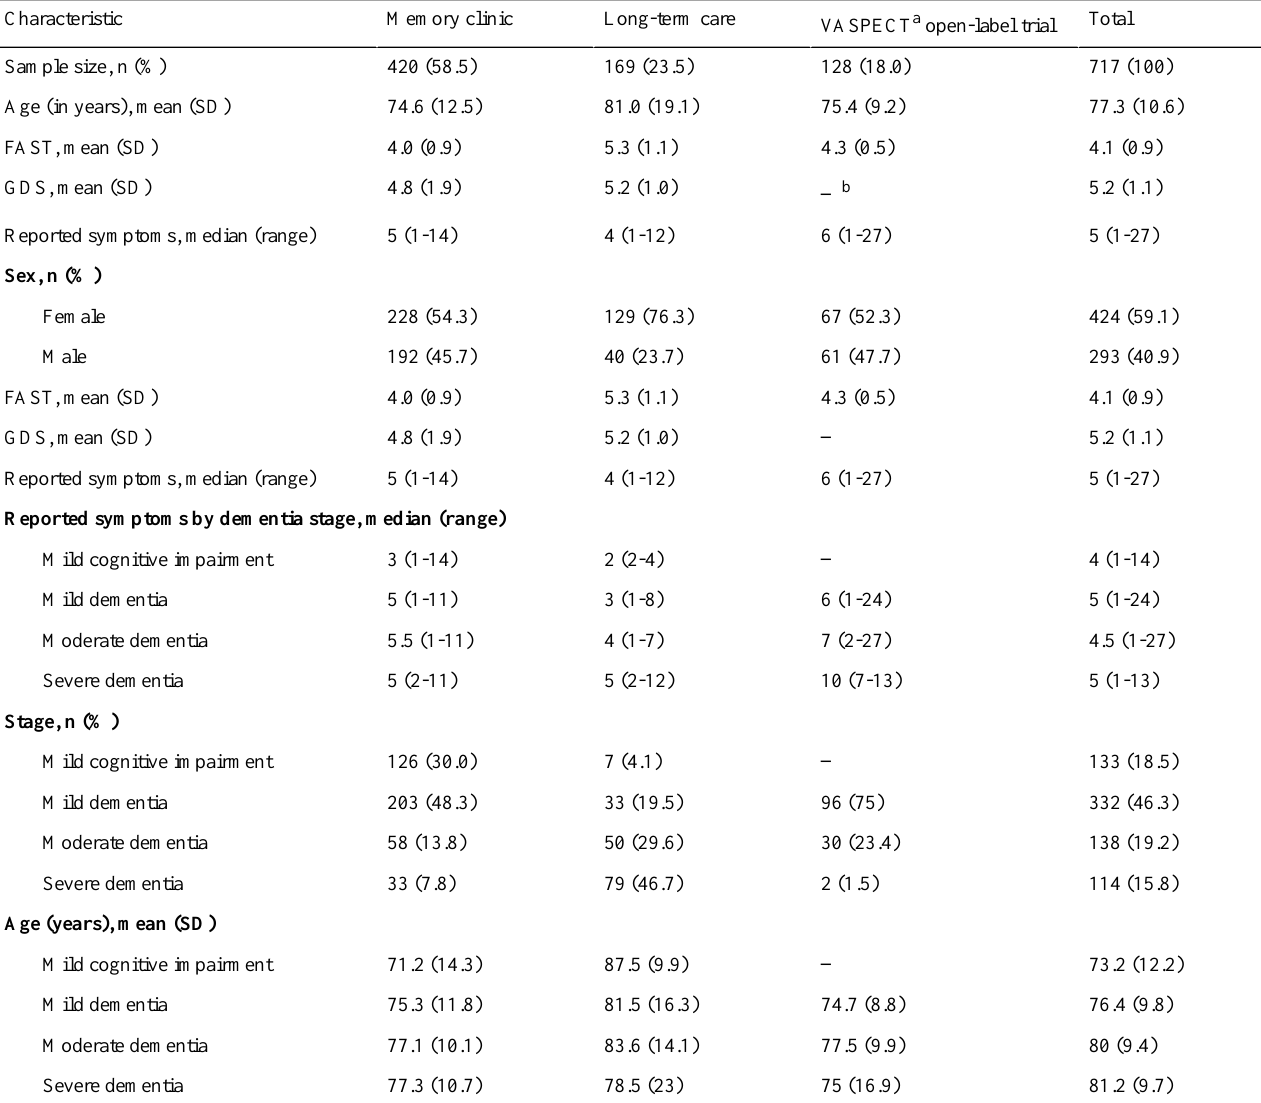
Table 1. Descriptive statistics of participants from clinical studies, by data source.